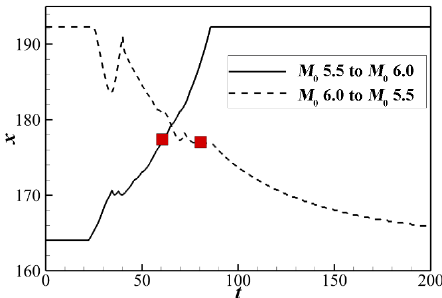
Figure 11. Shock-front positions along a line near the upper wall ( y = 145).